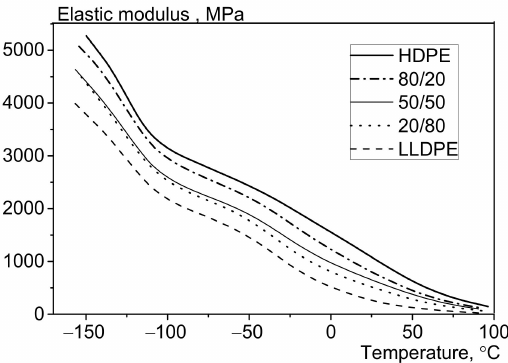
Figure 14. The effect of LLDPE on the elasticity modulus of the HDPE/LLDPE blends (DMA).